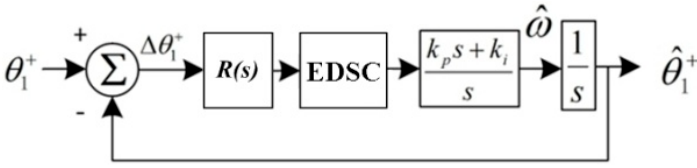
Figure 13. Small-signal model of the proposed PLL.